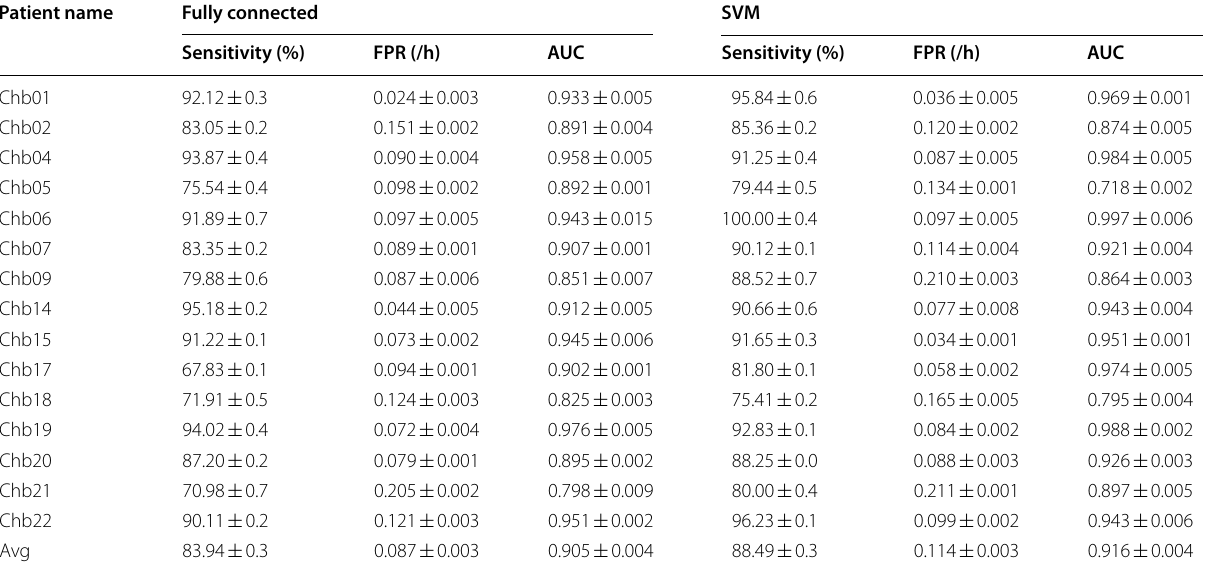
20 min, SPH 10 min) = =